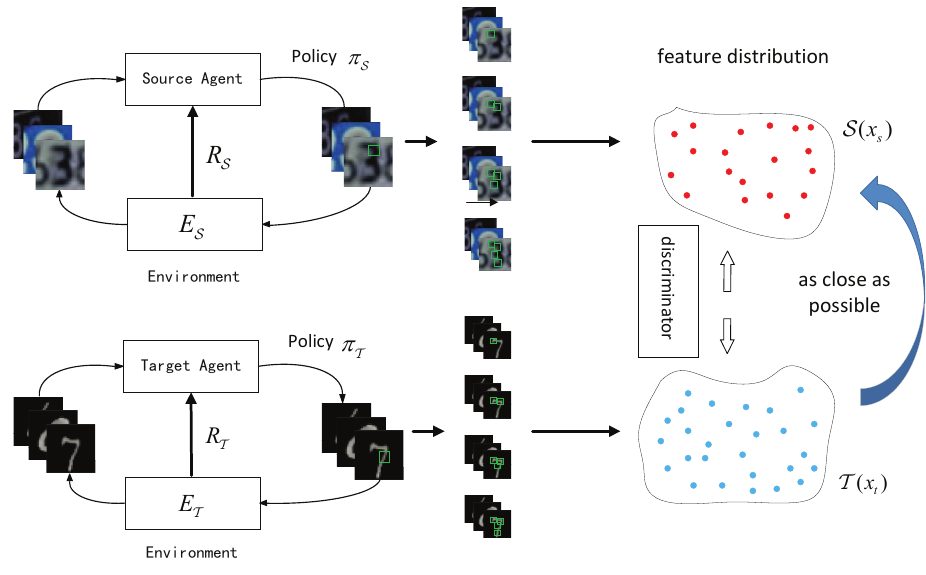
Figure 1. Illustration of the adversarial hard attention adaptation framework. Source images and target images are represented as the source environment E S and target environment E T respectively in this reinforcement learning framework. Policy π S is learned based on the classical hard attention method in the source domain. Policy π T is trained via our proposed adversarial reward strategy to extract the target attention feature T ( x t ) closing enough to the source model; on the other hand, the discriminator D is trained to distinguish the target attention feature from the source attention